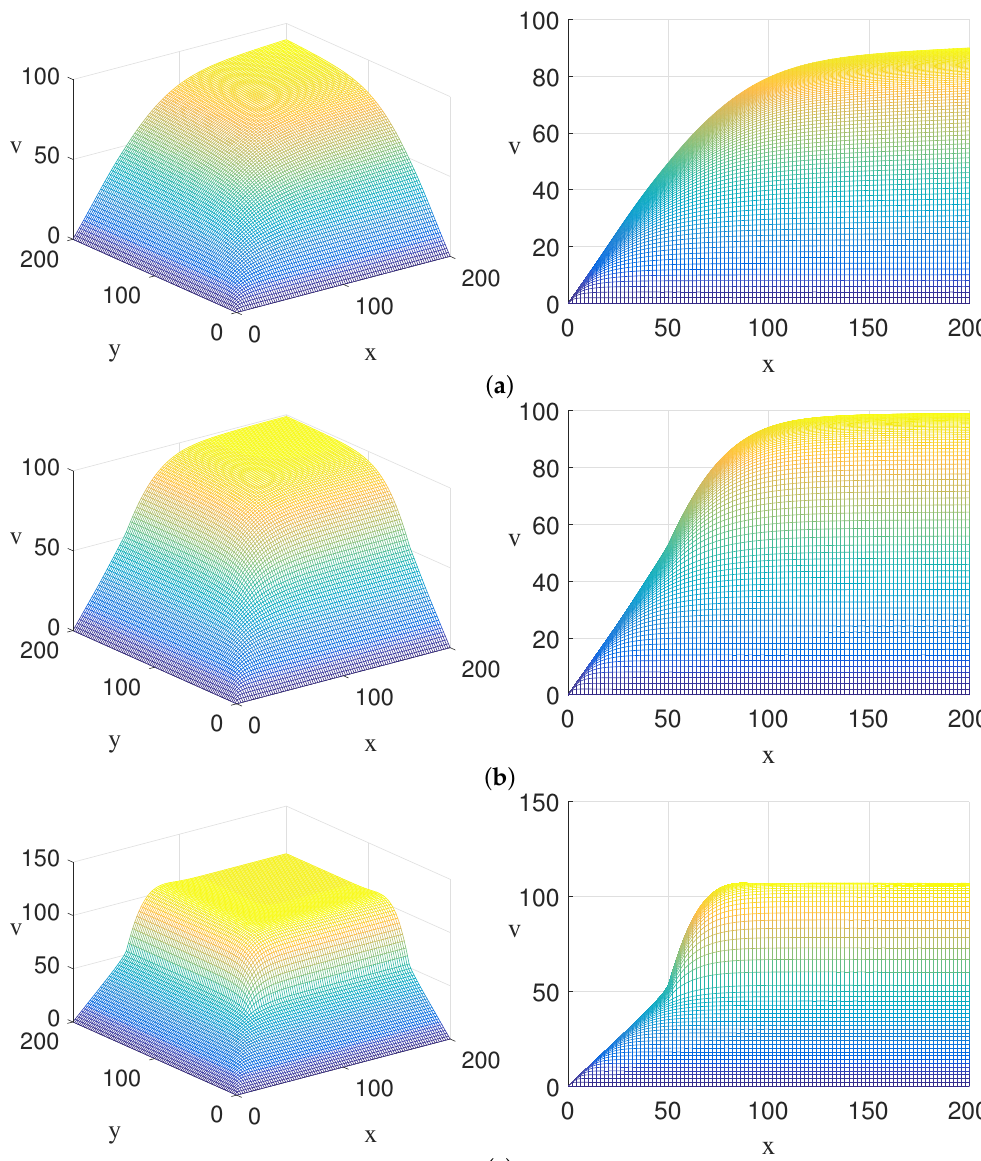
Figure 10. ( a ) denotes v for different x , y when H x = H y = H z = 0.3 and z = 100, ( b ) denotes v for different x , y when H x = H y = H z = 0.5 and z = 100 and ( c ) denotes v for different x , y when H x = H y = H z = 0.7 and z =